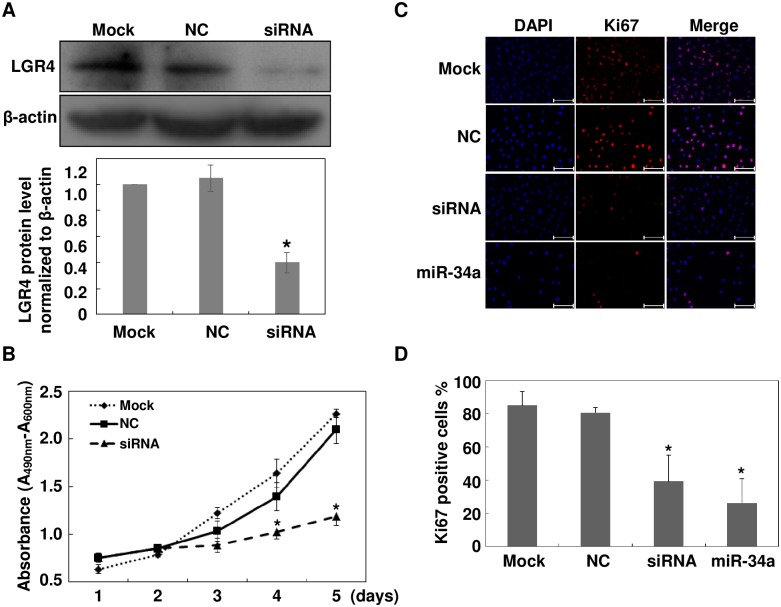
Knockdown of LGR4 inhibits ARPE-19 cell proliferation.Either a miR-34a mimic, LGR4 specific siRNA or a negative control (NC) was transfected into ARPE-19 cells. (A) Western blot analysis evaluated knockdown efficiency. The band intensity was measured with ImageJ software and normalized to the expression level in mock-treated cells. (B) MTS assay measured cell proliferation rates. Data at each time point were expressed as mean ± SD of the results obtained from three independent assays each performed in triplicates. (C) Ki67 immunostaining identified proliferating cells 48 hours after transfection. Images are representative of those obtained in three independent experiments. Scale bar: 200 μm. (D) Ki67 positive cells were expressed as percentages based on the number of Ki67 positive cells in three visual fields divided by the number of DAPI positive cells. Results are expressed as mean ± SD. n = 3, *p < 0.05.